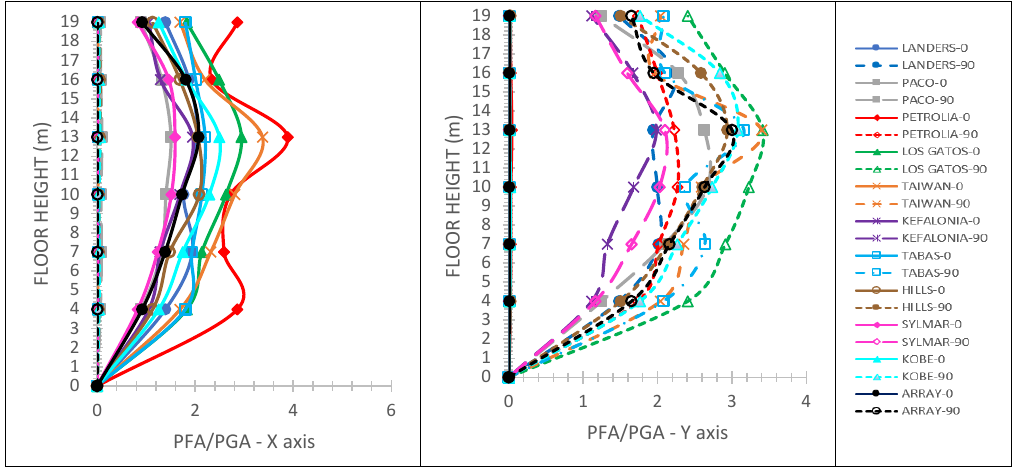
Figure 22. PFA/PGA along X ( left ) and Y ( right ) horizontal directions of the six-story mixed building, considering the fixed-pinned connection of the steel structure to the r/c one.